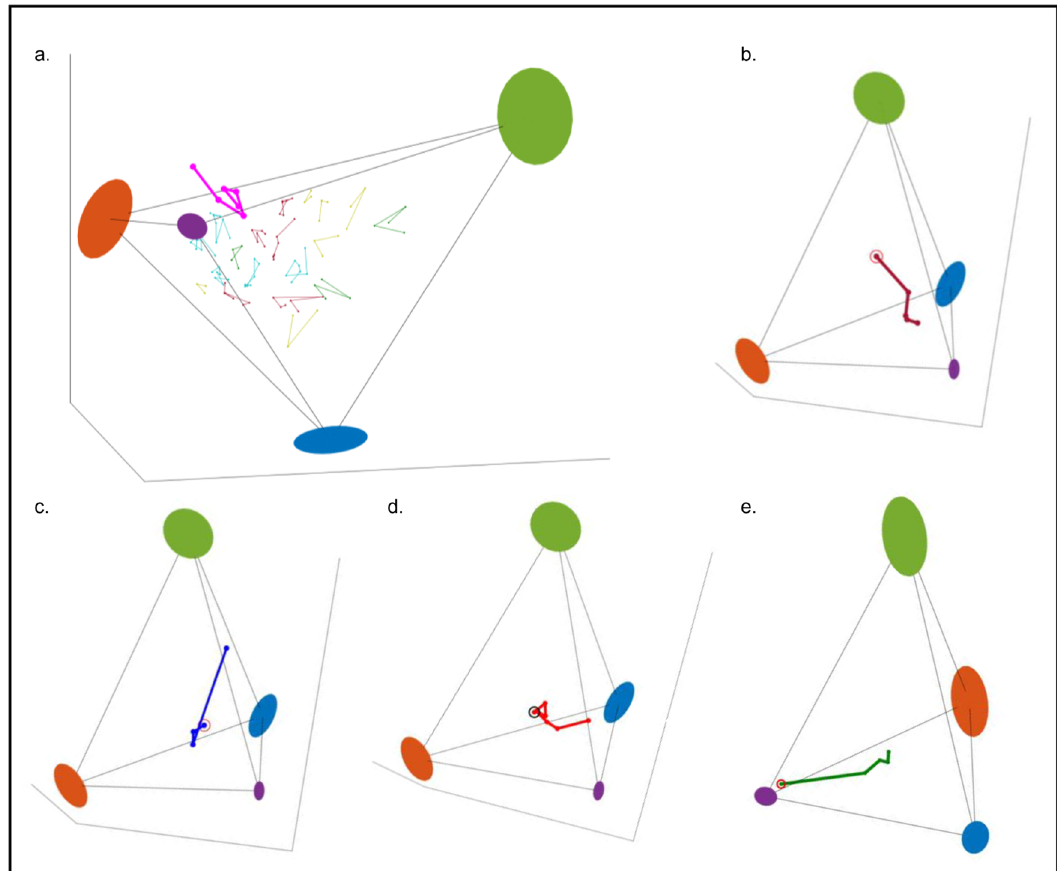
Fig. 6 Trajectories of individuals and the movement on the tetrahedron can be used for early detection of transitions from health to disease state. a most individuals tumble around their initial position on the tetrahedron. Shown in the Figure are a few examples of trajectories, colored according to the number of timepoints: yellow- 3, green-4, red-5 and 6, and turquoise- 7 timepoints, the initial position is marked with a black circle. The pink trajectory belongs to a 64-year-old woman who was diagnosed with stage 3 bladder cancer prior to her blood measurements, her trajectory exceeds the boundaries of the tetrahedron. b Most of the trajectories are moving away from the unhealthy- archetype (green) towards the older and the healthy archetype (purple), as expected from a wellness program. Shown in the Figure an example of such a trajectory. c The trajectory of a 56-year-old woman that signi fi cantly progressed in her 4 th time-point (Euclidean distance: 13.2) towards the unhealthy-archetype (green) and closer to the male-archetype (blue), 3 days prior to a diagnosis of enlarged liver, gallbladder and pancreas. d The 7 timepoints trajectory of a 61-year-old woman, tumbling in the middle of the tetrahedra in the fi rst 3 timepoints, and starting from the 4th time-point, gradually moving horizontally away from the female-archetype (orange) towards a point between archetype 1 and 3. Between her 6 th and 7 th visits she was diagnosed with Gallstones and Fatty liver disease. e A gradual trajectory of a 56- year-old man, who was not diagnosed with any disease, but consistently moves away from the healthy and the older archetype (purple) towards the center of the tetrahedron, and closer to the unhealthy